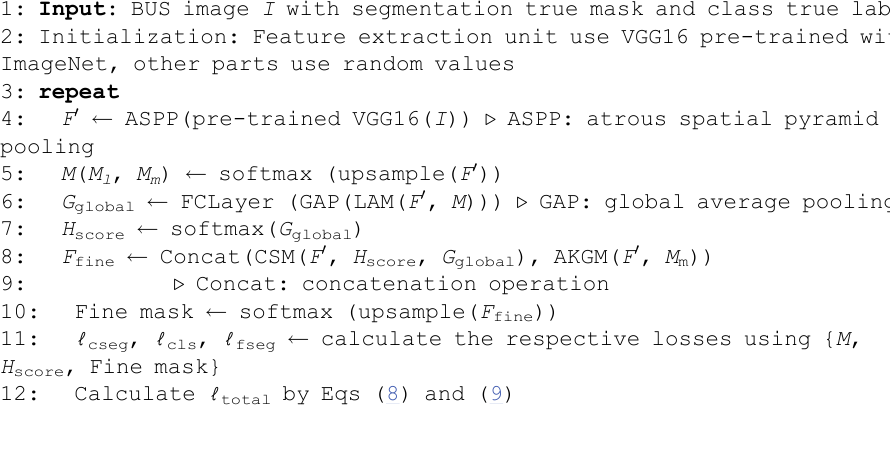
Algorithm 1 Cross-task guided network